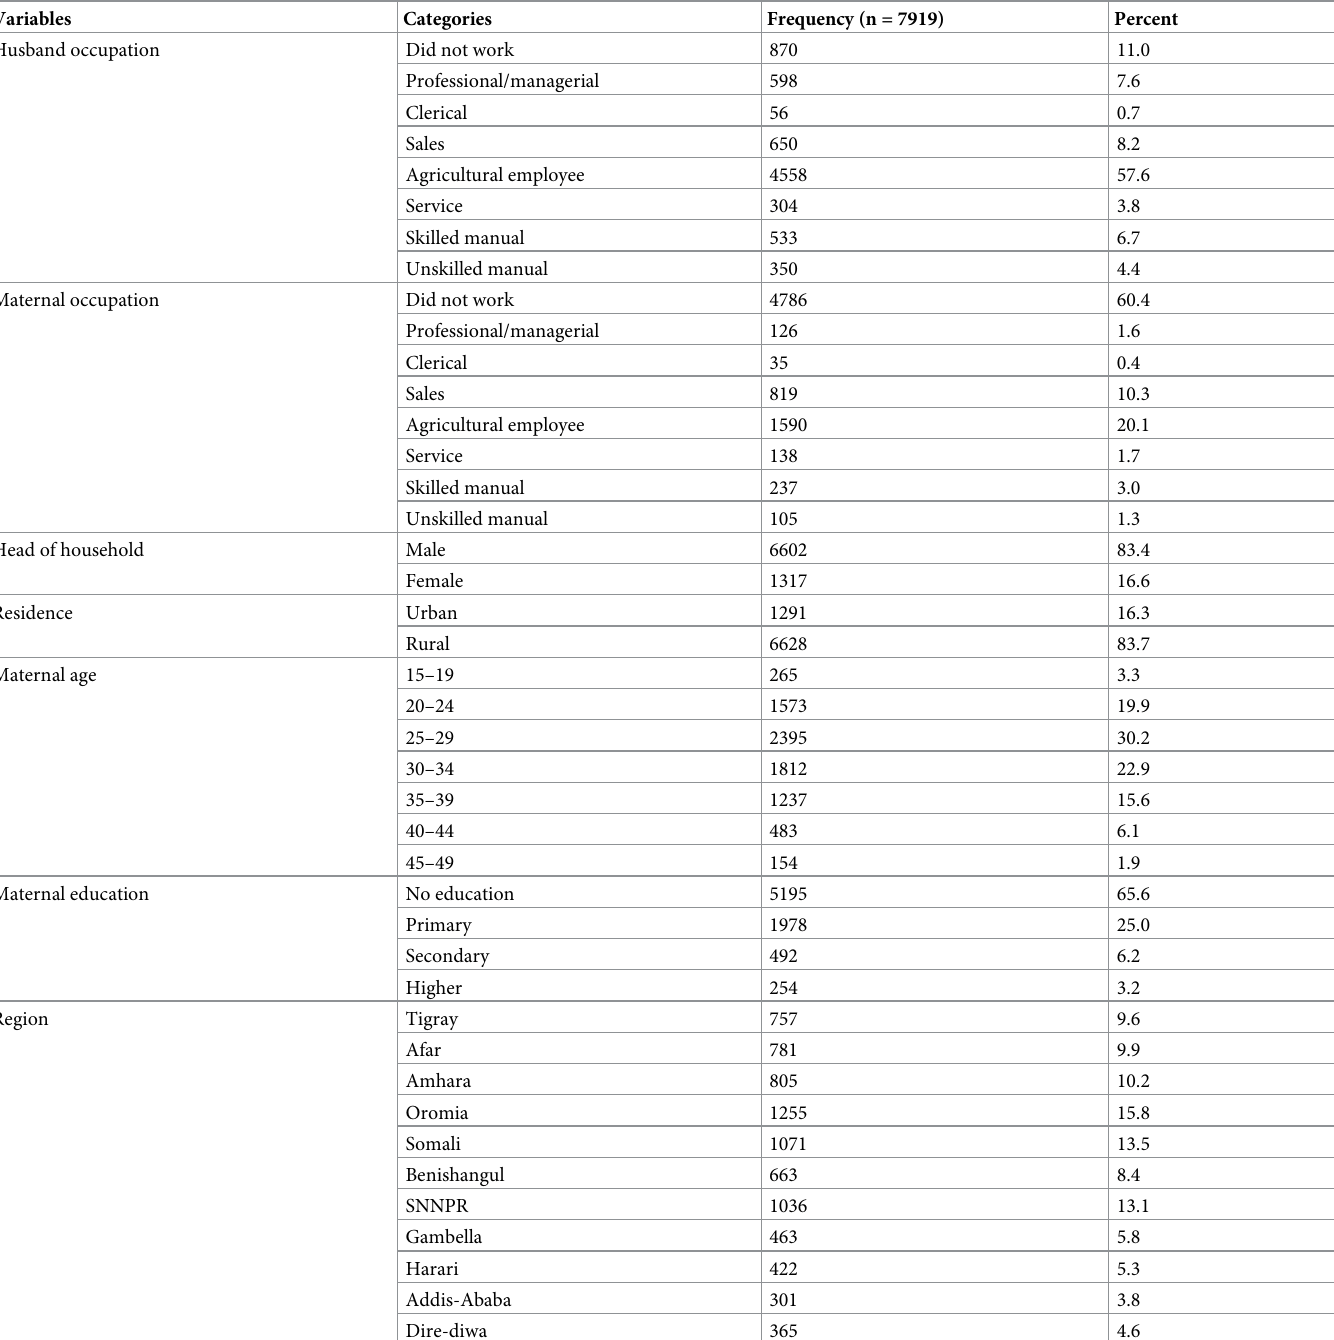
Table 1. The socio-demographic, behavioral, and medical history of respondents and their children under-five years of age in Ethiopia.